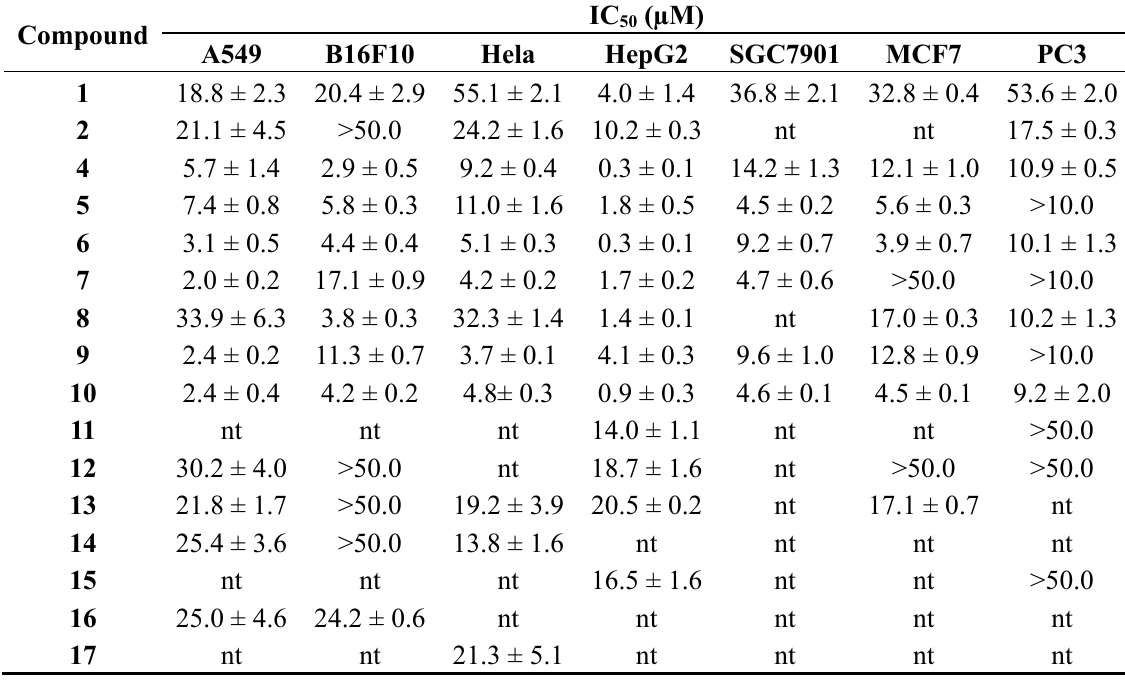
Table 1. Inhibitory effects of AA and derivatives on proliferation of A549, B16F10, Hela, HepG2, SGC7901, MCF7 and PC3